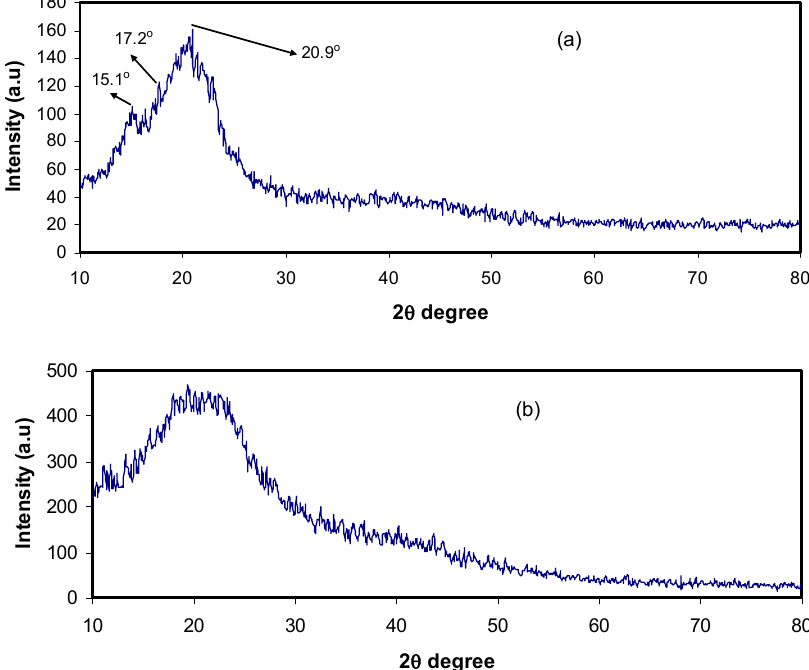
Figure 1. the XRD pattern for ( a ) pure CS and ( b ) CS:Dextran blend film.